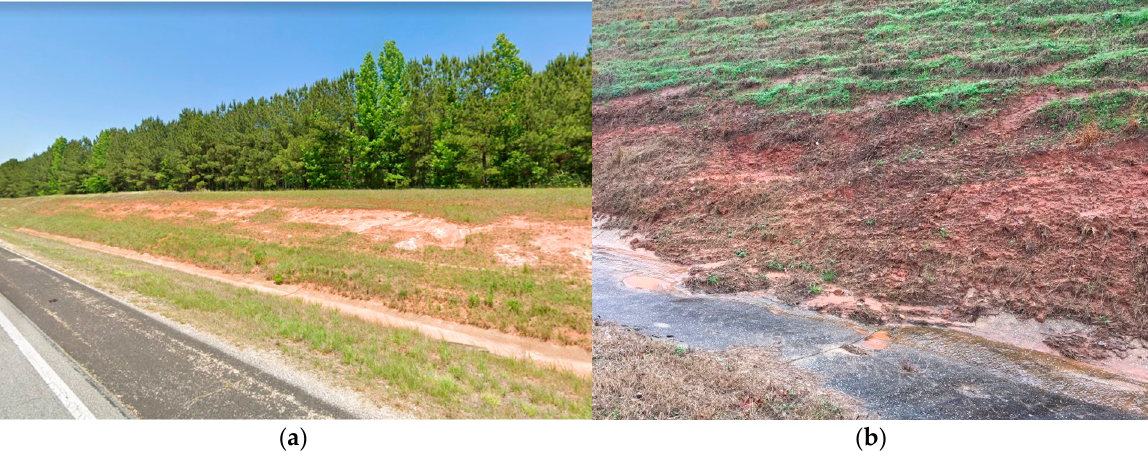
Figure 1. Eroded slopes along ( a ) US-280 near Waverly, Alabama (photo from Google StreetView) and ( b ) Alabama Highway 69 near Tuscaloosa, Alabama (photo provided by Jacob Hodnett, ALDOT).